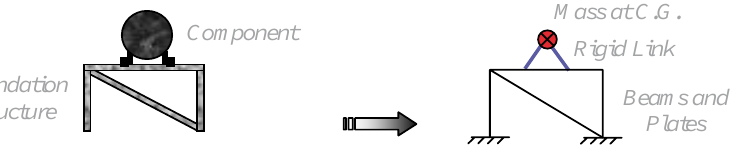
Fig. 1. Typical shock analysis model for DDAM.